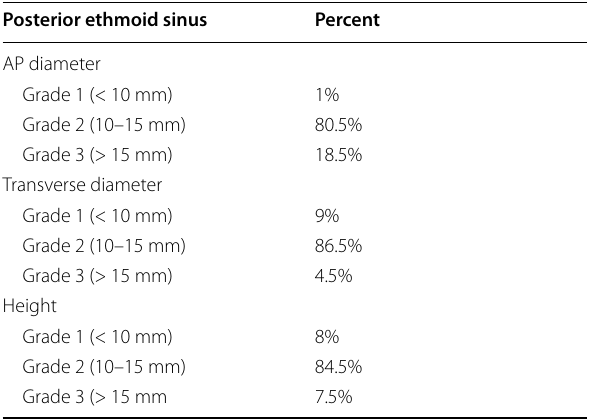
Table 3 Grading for the different dimensions of the posterior ethmoid sinus and its incidence Posterior ethmoid